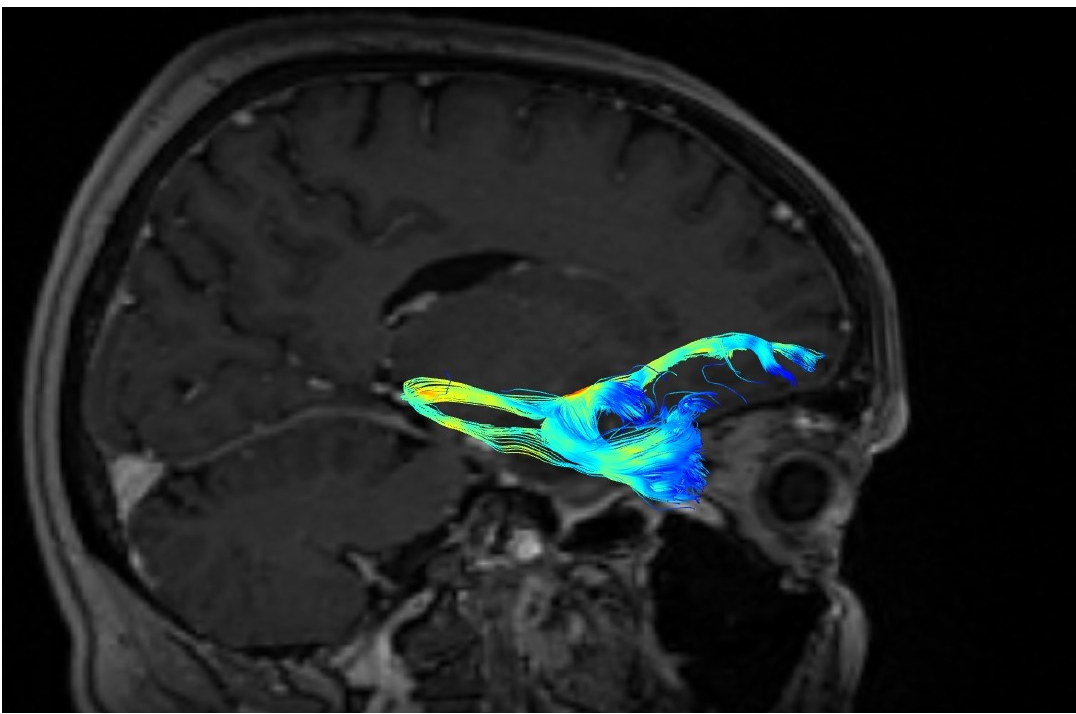
Figure 3. U-shape of the uncinate fasciculus (UF).